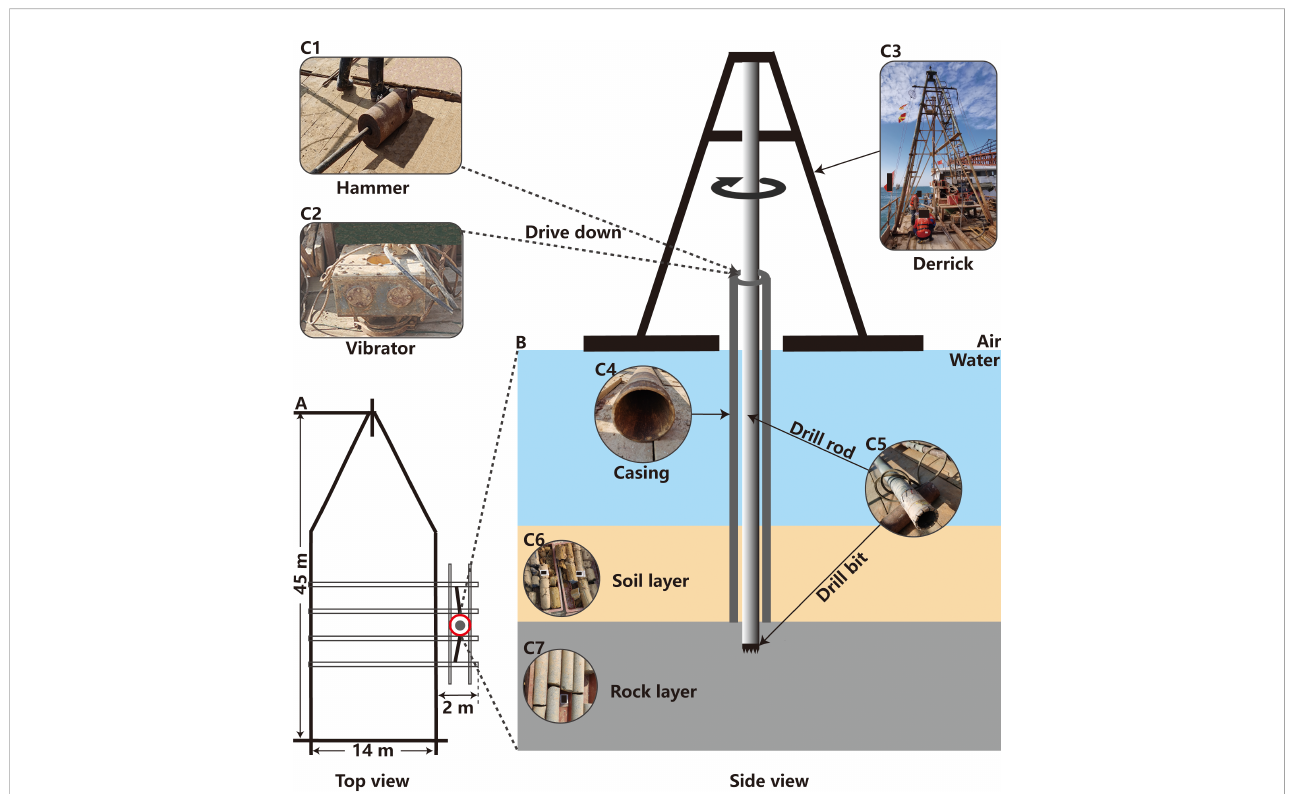
FIGURE 1 Schematic diagram of offshore exploration drilling (OED) on standard vessel [ (A) : top view of OED platform; (B) : side view of OED construction]. (C1, C2) : the hammer and vibrator used to drive down the casing (C4) ; (C3) : the derrick for fi xing drilling machines; (C5) : the drill rod, which uses the drill bit at the end to obtain the samples of soil layer (C6) and rock layer (C7)